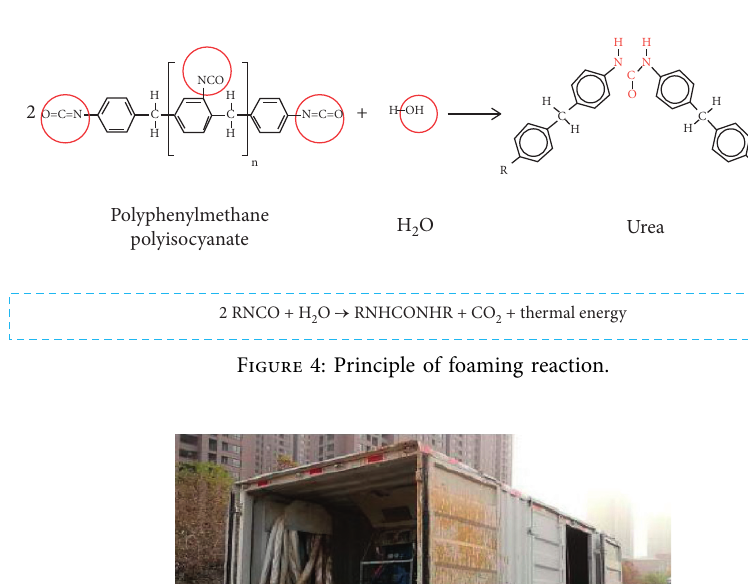
Figure 3: Principle of gel reaction.